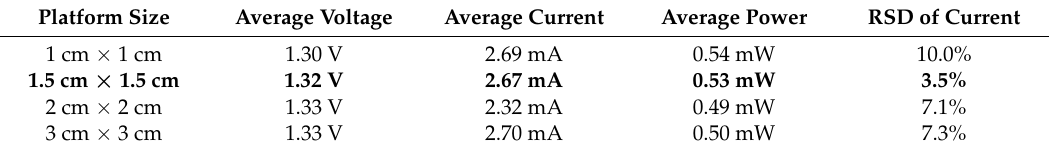
Table 2. Voltage, current, and power of varying chip sizes using constant electrolyte concentration (1 M KOH) and constant electrode size 0.5 cm 2 (1 cm × 0.5 cm). The optimal chip size was 2.25 cm 2 (1.5 cm × 1.5